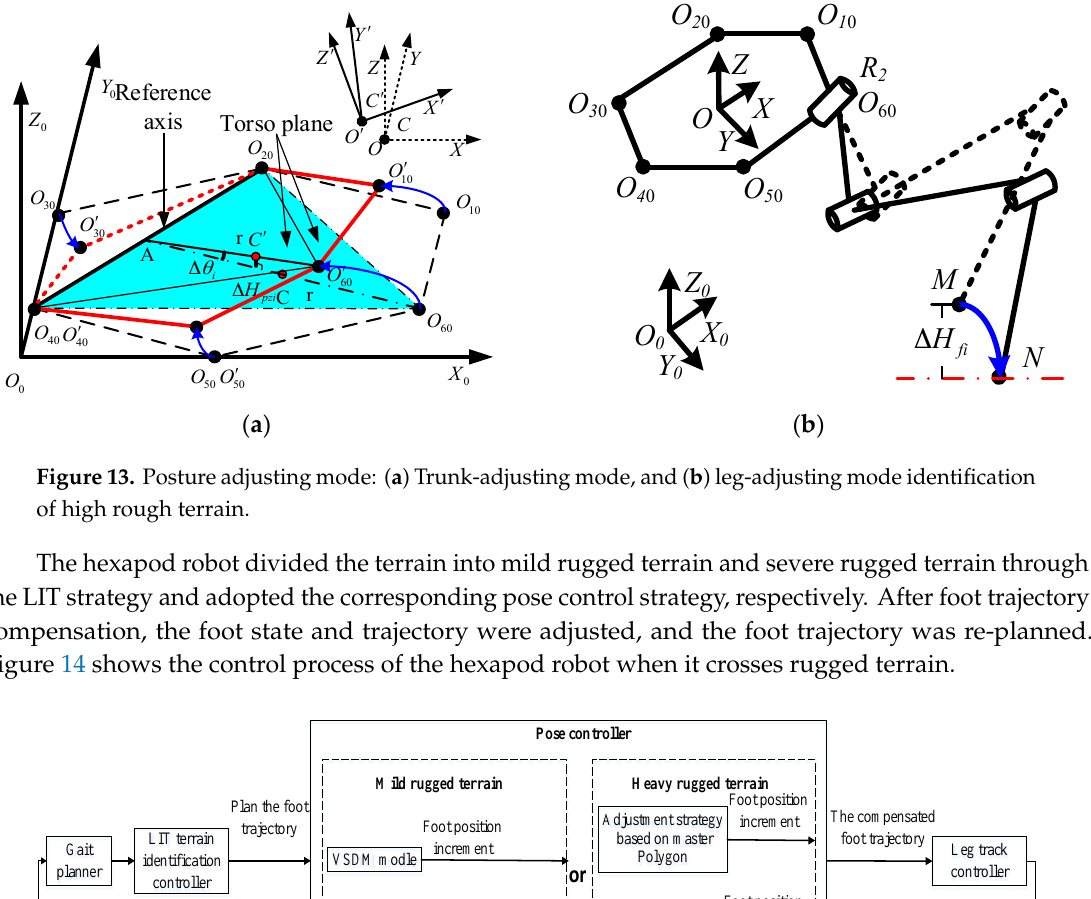
( b ) Figure 15. Posture control simulation in MATLAB: ( a ) Simulation environment of unstructured terrain walking, and ( b ) projection on the XY plane of MP. Figure 16 shows the curves of the trunk yaw angle, pitch angle, and roll angle. Each curve either maintains a zero value or changes smoothly and slowly at different stages. This control method can make the robot switch between mild and severe rough posture control mode in a timely manner with the change of terrain. In addition, it can adapt to the changing rugged terrain and complete the walking of the complex terrain through the posture adjustment of severe rough terrain. Z